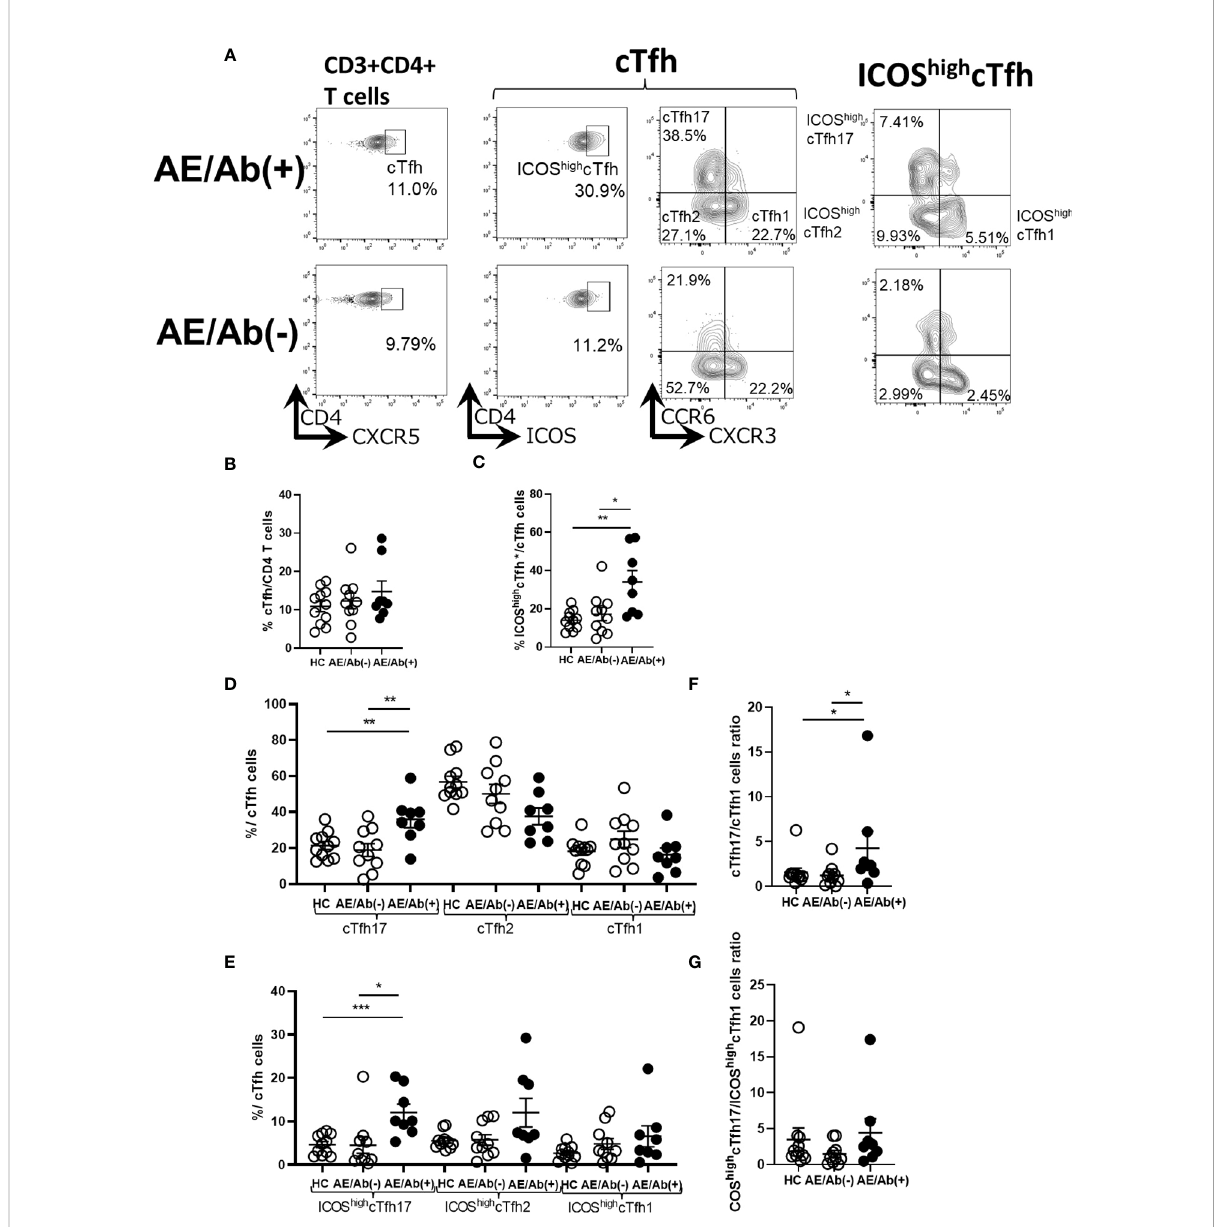
FIGURE 2 cTfh subset shifts to induce B cell differentiation in patients with AE/Ab(+). (A) Representative fl ow cytometry analysis of CD3+CD4+CXCR5+ T cells(cTfh), CD3+CD4+CXCR5+ICOS high CD4 T cells (ICOS high cTfh), CXCR3+CCR6 − CXCR5+CD4 T cells(cTfh1), CXCR3 − CCR6 − CXCR5+CD4 T cells (cTfh2), CXCR3 − CCR6+CXCR5+CD4 T cells (cTfh17), CXCR3+CCR6 − CXCR5+ICOS high CD4 T cells (ICOS high cTfh1), CXCR3 − CCR6 − CXCR5 +ICOS high CD4 T cells (ICOS high cTfh2), and CXCR3 − CCR6+CXCR5+ICOS high CD4 T cells (ICOS high cTfh17) in PBMCs. (B) The frequency of cTfh within CD4 T cells in HC, patients with AE/Ab(-) and AE/Ab(+). (C) The frequency of ICOS high cTfh within cTfh in HC and patients with AE/Ab(-), AE/Ab(+). (D) The frequency of cTfh17, cTfh2, and cTfh1 within cTfh in HC, patients with AE/Ab(-) and AE/Ab(+). (E) The frequency of ICOS high cTfh17, ICOS high cTfh2, and ICOS high cTfh1 of cTfh in HC and patients with AE/Ab(-) and AE/Ab(+). (F) cTfh17/cTfh1 cells ratio of cTfh in HC, patients with AE/Ab(-) and AE/Ab(+). (G) ICOS high cTfh17/ICOS high cTfh1 cells ratio in HC, patients with AE/Ab(-) and AE/Ab(+). HC (n=11), AE/ Ab(-) (n=10), and AE/Ab(+) (n=8). Values are expressed as the mean ± SEM. *p < 0.05, **p < 0.01 and ***p < 0.001; two-sided unpaired t -test or Mann-Whitney U test, as appropriate. HC, healthy controls; AE/Ab(-), antibody-negative suspected autoimmune epilepsy; AE/Ab(+), antibody- positive autoimmune epilepsy; cTfh, circulating follicular helper T cell; ICOS, inducible T-cell